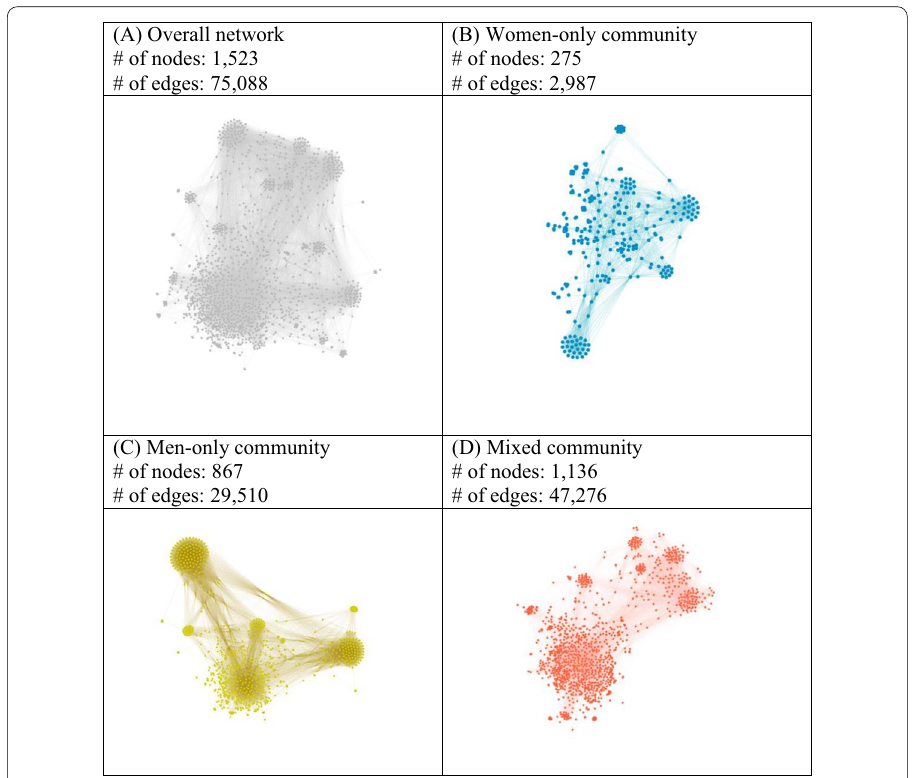
Fig. 1 One-mode film festival network and its gendered